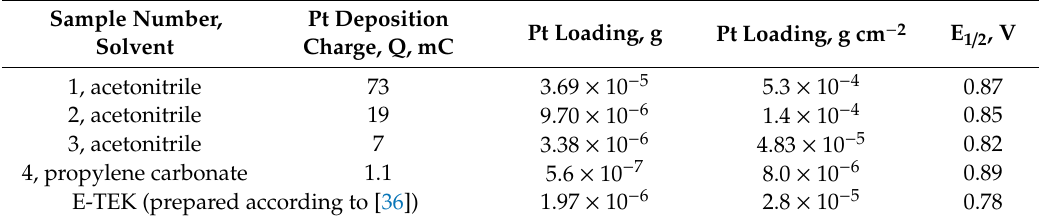
Figure 4. XPS spectra of the mixed Pt/Cu catalyst: ( a ) Cu spectrum, ( b ) Pt spectrum, ( c ) O spectrum.